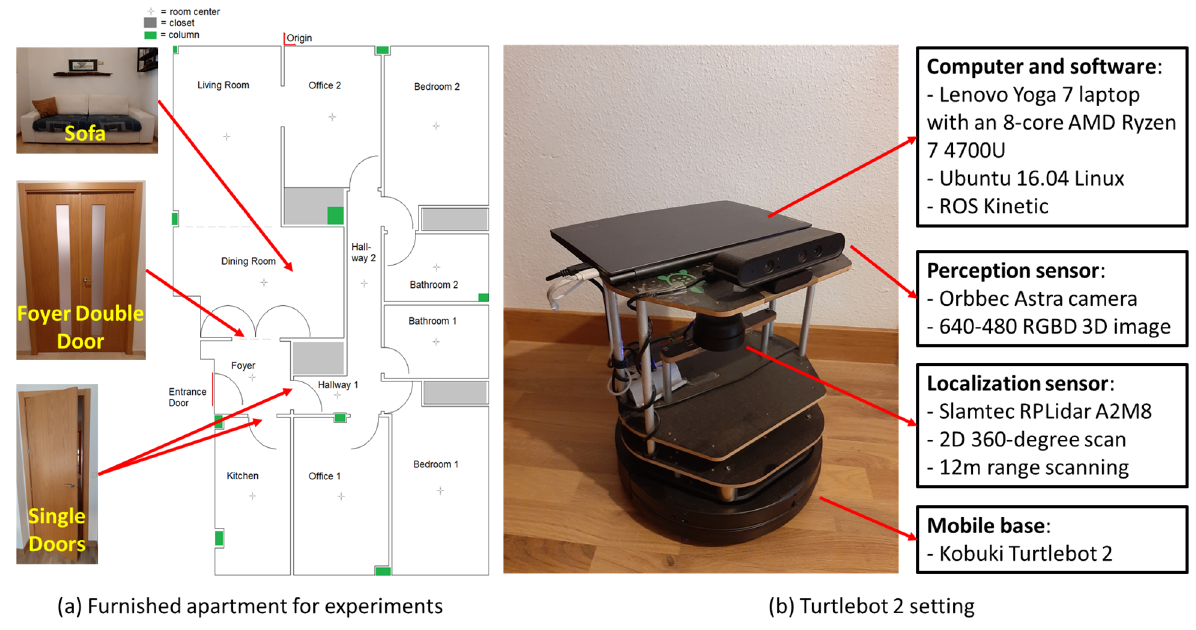
Figure 9. ( a ) Furnished apartment for experiment and ( b ) Turtlebot2 with RGBD and 2D LiDAR sensors.